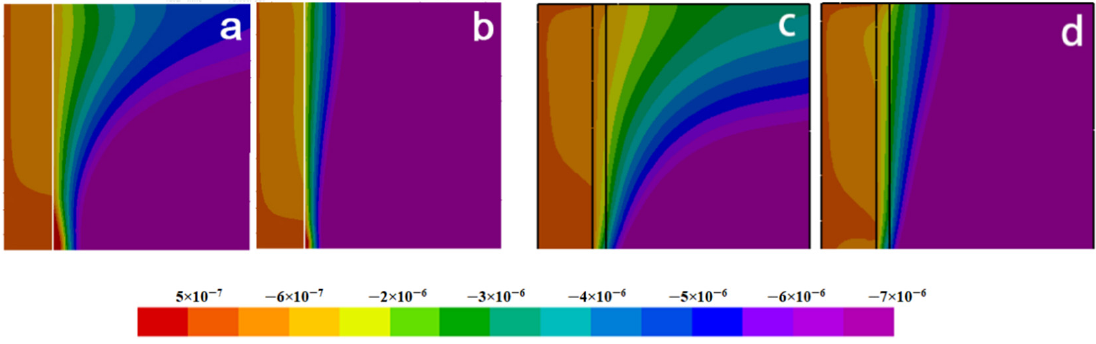
Figure 10. Distributions of radial deformation: ( a ) Fo = 0.156, without coating; ( b ) Fo = 0.234, without coating; ( c ) Fo = 0.156, with coating; ( d ) Fo = 0.234, with coating.